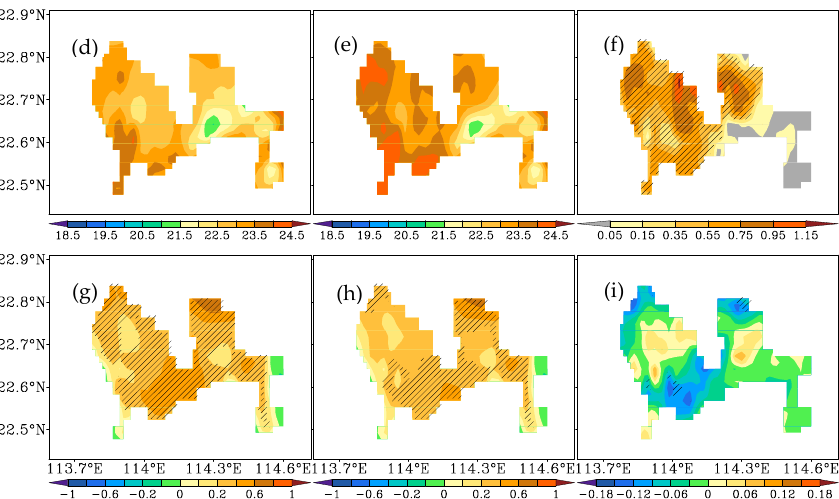
Figure 4. Spatial distributions of ( a , b ) T 4 and ( d ,e) T xn , and ( g , h ) the corresponding differences (T xn minus T 4 ) under ( a , d , g ) EX1 and ( b , e , h ) EX2 for 1980 and 2016. ( c , f ) The 37-year averaged warming for ( c ) T 4 and ( f ) T xn , and ( i ) the corresponding differences over Shenzhen (oblique line denotes passing the 90% confidence level significance t-tests, units: °C).